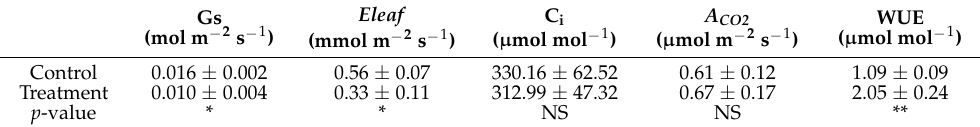
Table 1. Gas exchange parameters of control plants and plants treated with Archer ® Eclipse.